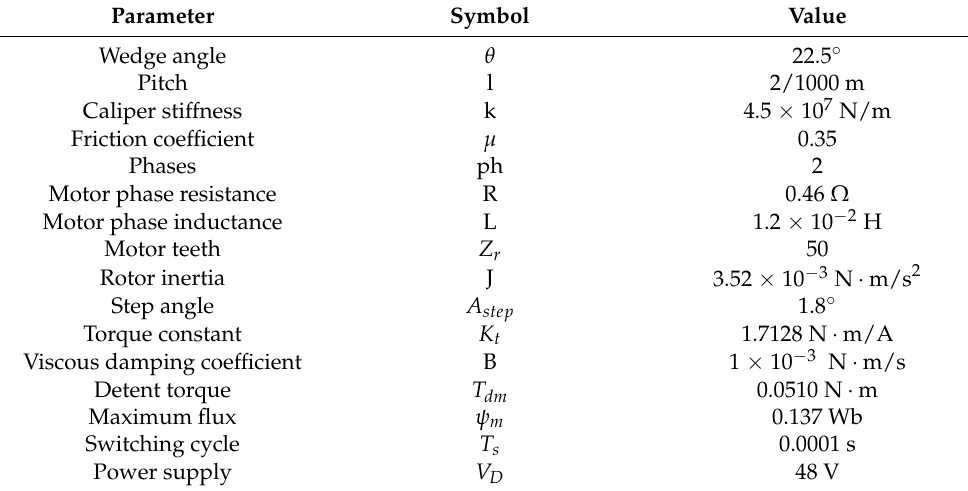
Table 1. The parameters of the proposed EWB